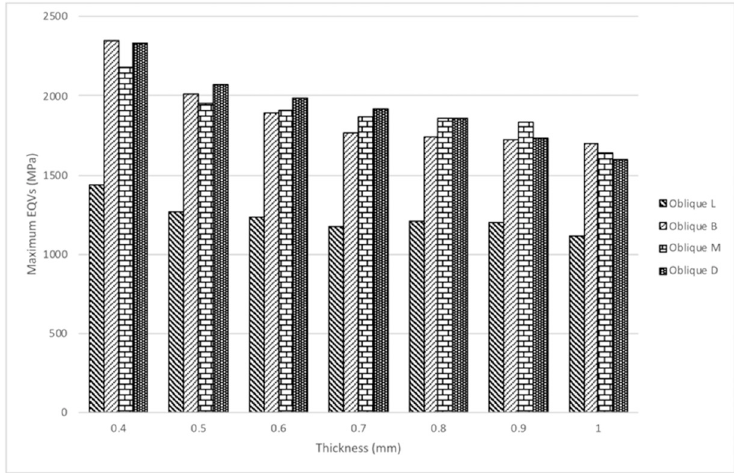
Figure 6. Comparison of EQVs in zirconia specimens with seven thickness under four different oblique 10-degree loading directions with 800 N force. The lowest value occurred when the thickness was 1.0 mm under lingual side loading. L: lingual, B: buccal, M: mesial, D: distal.